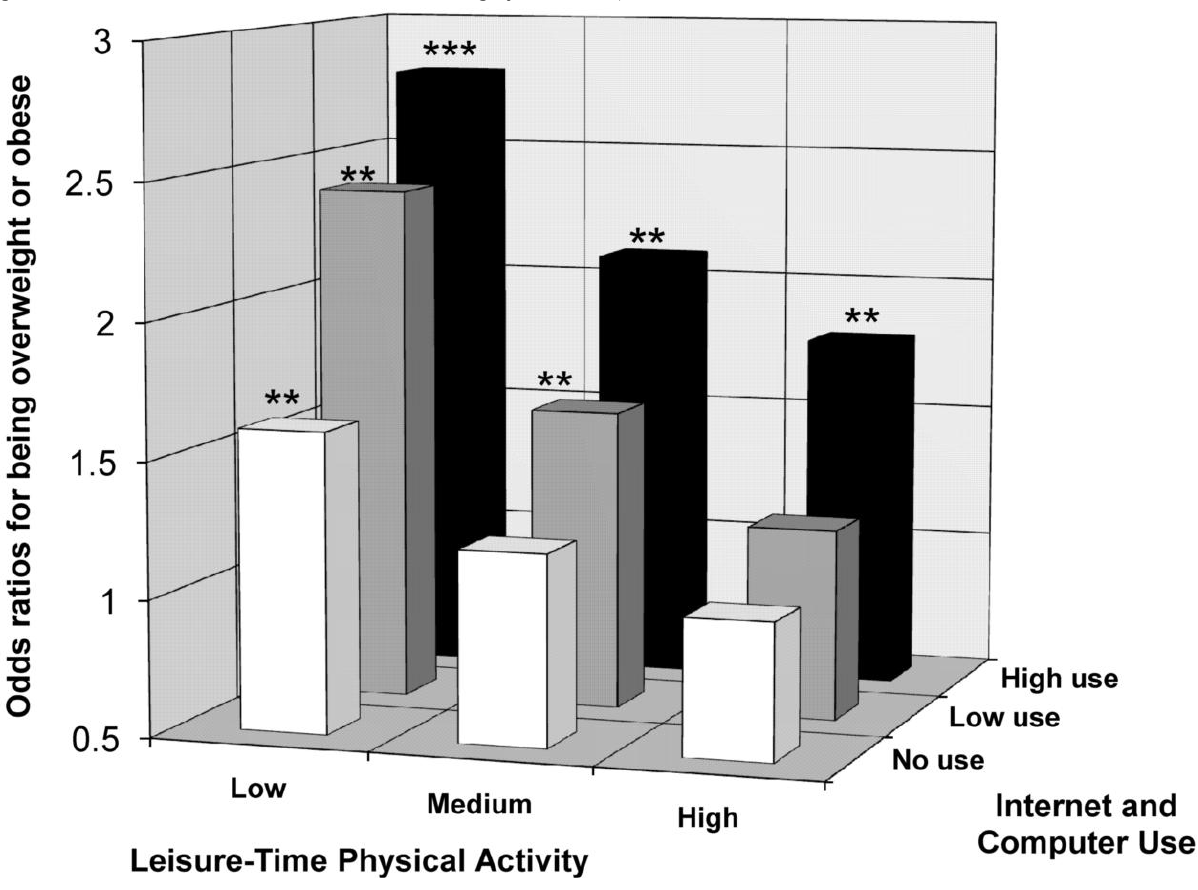
Figure 1. The odds ratios for being overweight or obese (BMI ≥ 25), according to combined categories of Internet and computer use (no, low, and high leisure-time Internet and computer use) and physical activity (low, medium, and high leisure-time physical activity). The reference category is having high leisure-time physical activity and not using the Internet and computer, for which the odds ratios are equal to 1. The significance levels on top of the figure bars are differences in relation to the reference category: ** P < .01; *** P <